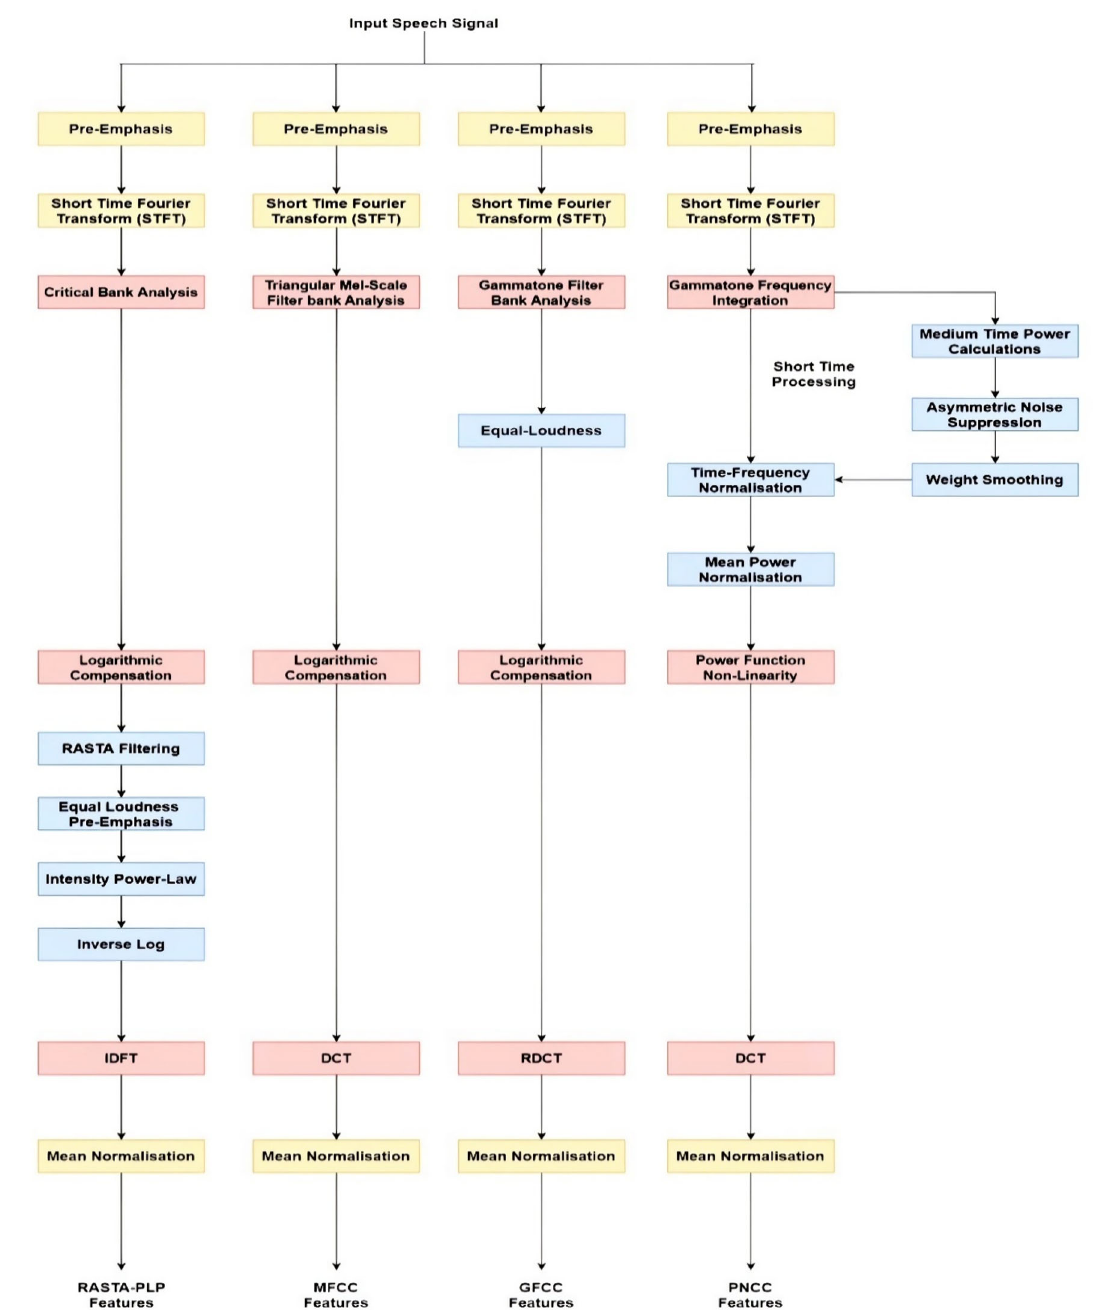
Fig. 1 A comparative block diagram of heterogeneous front-end feature extraction approaches